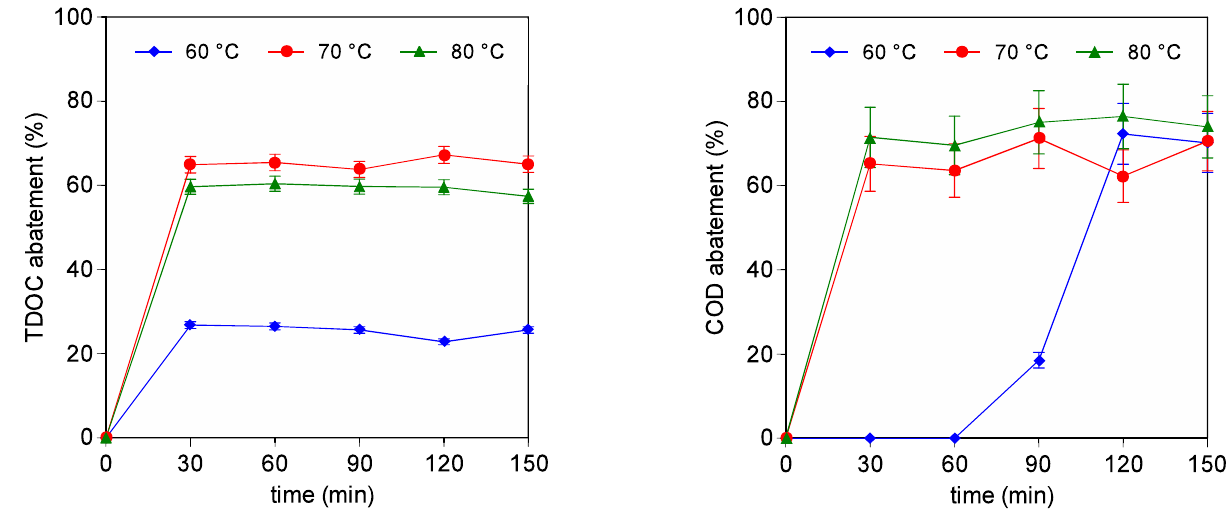
Figure 3. Effect of reaction temperature on TDOC and COD removal efficiencies (reaction condition: pH 5, 200 mg/L of catalyst, H 2 O 2 30 mL/L and reaction time 150